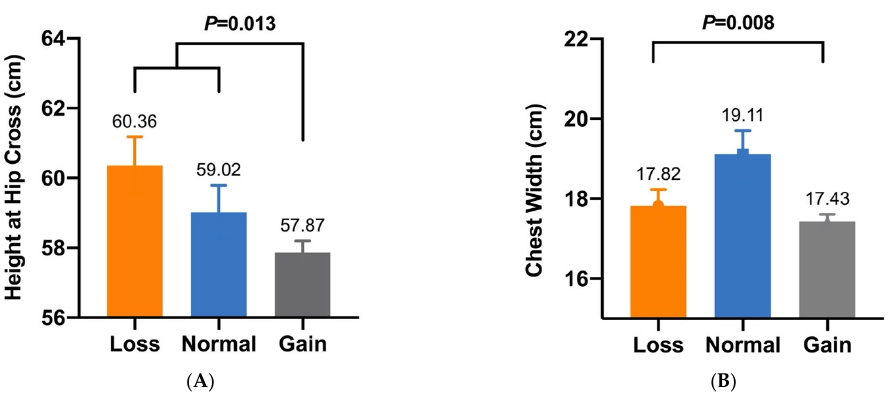
Figure 3. Association analysis between CNV2 and morphometric traits in SBWC goats: ( A ) height at hip cross and ( B ) chest width.